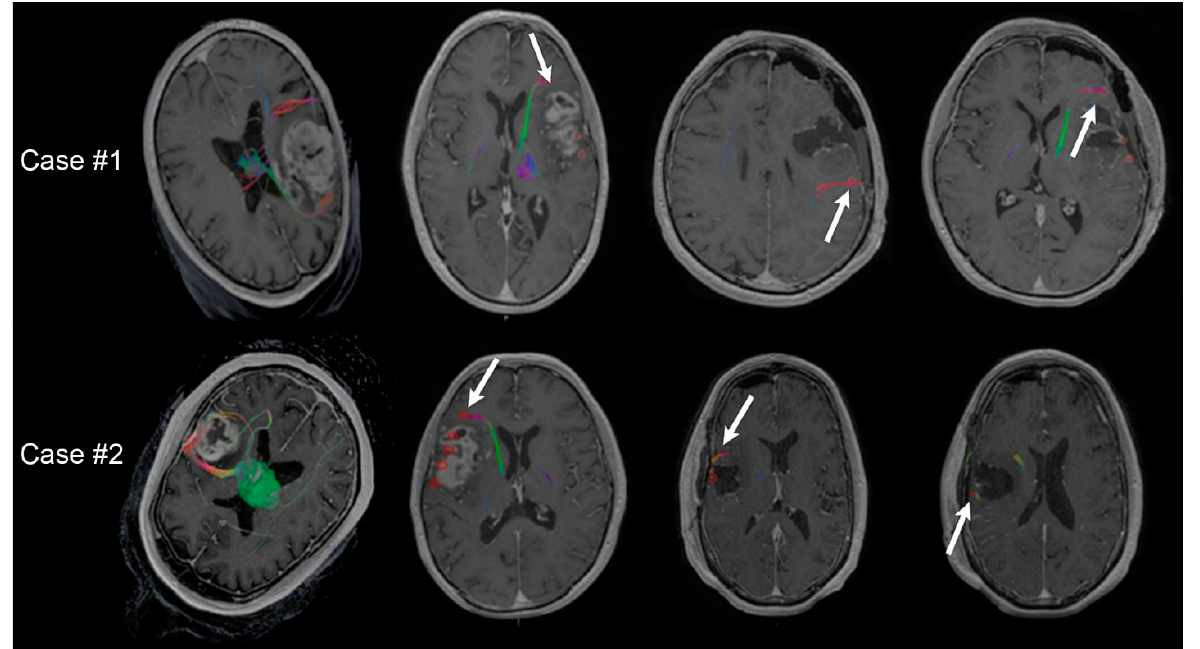
Figure 5. Case illustration of two patients without permanent motor deficits. Left picture shows TMS-seeded tractography at 75% FA threshold identifying white matter tracts splitting around the lesions. Positive TMS points spanned the entire lesions; however, white matter tracts only connected to the edges of the functional cortex. The resection removed the bulk of the TMS-positive cortex yet preserved the edges with connecting white matter tracts. The patient made a complete neurological recovery. Arrows indicate DTI tractography WMT connections to TMS